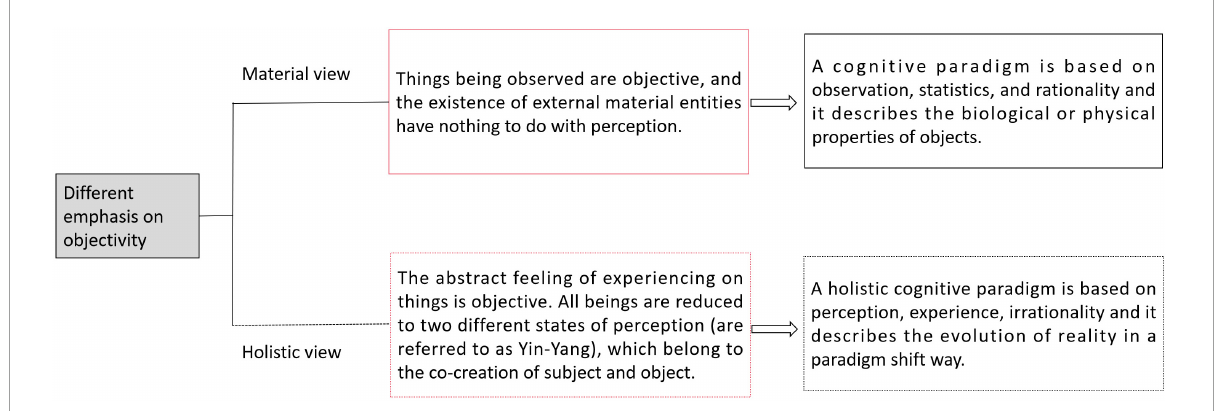
FIGURE2 Different characteristics of material view and holistic view. In these two different cognitive paradigms, we propose that the cognitive paradigm based on the view of matter has significant, concrete and widely disseminated characteristics. Holism, on the other hand, is inaccurate and abstract because of its reliance on experience and perception. The social applications derived from it have similar characteristics, focusing on the internal influence of external reality and purpose rather than tools invention. For example, traditional Chinese medicine, tenon and mortise, acupuncture and moxibustion, architectural style and soon. This paper tries to put forward a hypothesis that can be scientifically tested to prove the rationality of this philosophical paradigm and provide reference to solve the paradox of consciousness in biology and physics.